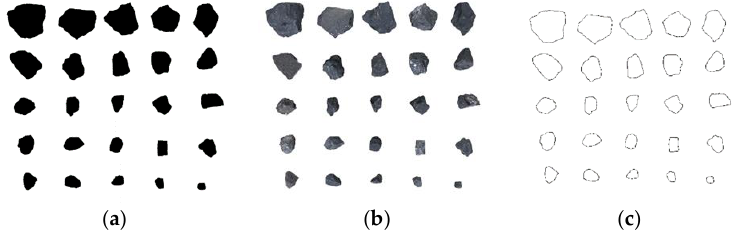
Figure 2. Statistical analysis of the shape of the gangue block. ( a ) High-definition digital image; ( b ) binary processing image; ( c ) the boundary contour image. ( b ) binary processing image; ( c ) the boundary contour